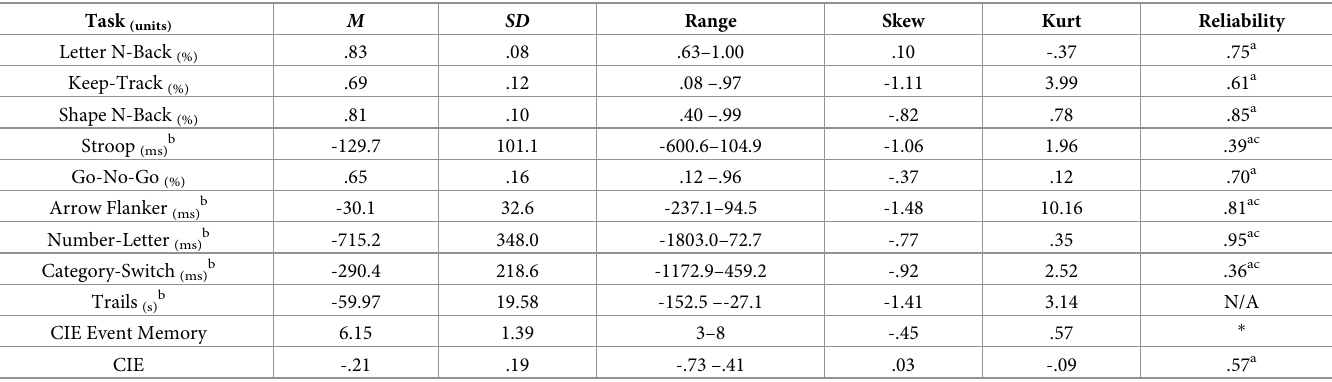
Table 1. Descriptive statistics and internal-consistency reliability for EF tasks and CIE task (N = 255).